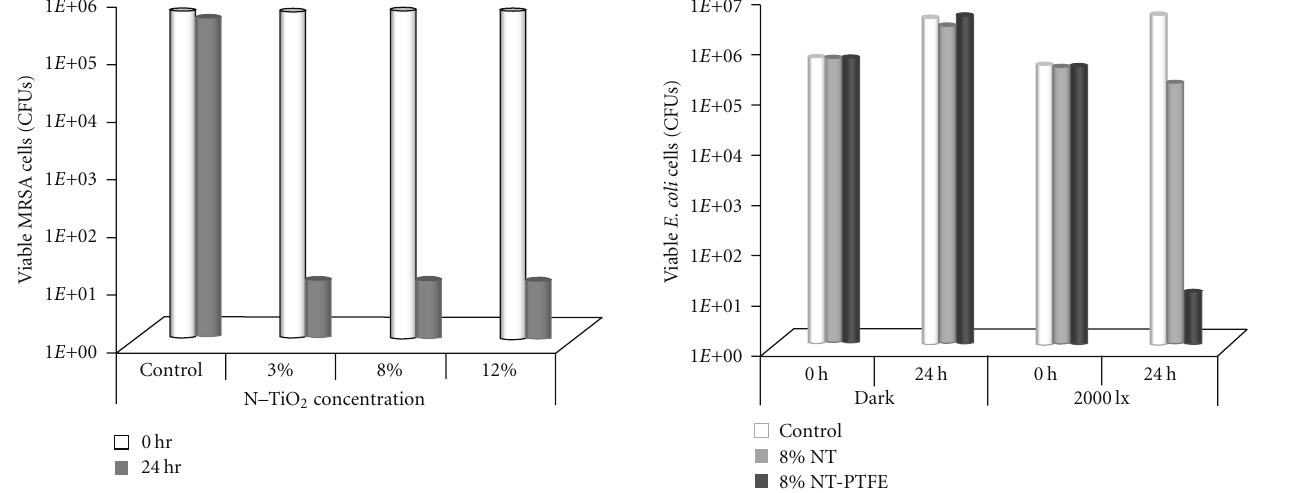
Table 2: Adhesion of E. coli onto the PTFE hydrophobic composite films with and without the addition of N-doped TiO 2 (NT).